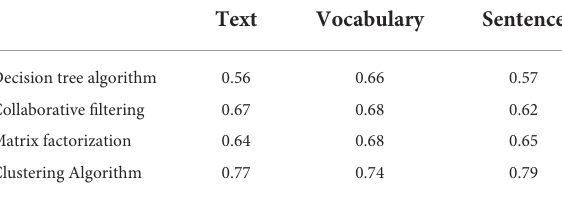
TABLE 1 Reliability analysis of big data mining algorithms.